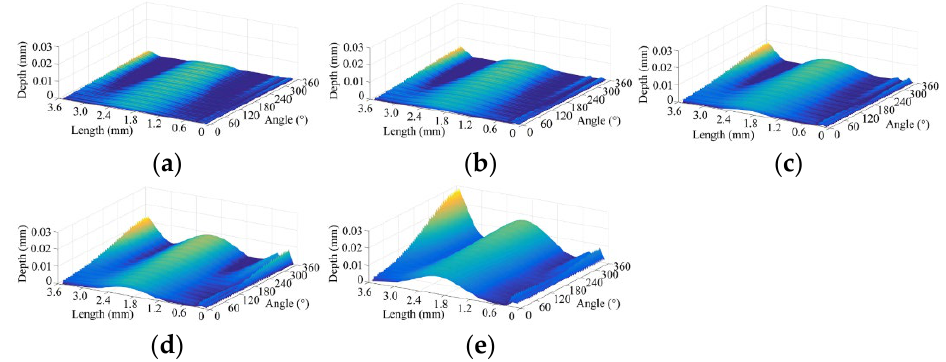
Figure 15. Calculated displacement of nodes at the inner side of C-ring under different working distances. ( a ) 1.8 km; ( b ) 3.6 km; ( c ) 7.2 km; ( d ) 14.4 km; ( e ) 28.8 km.